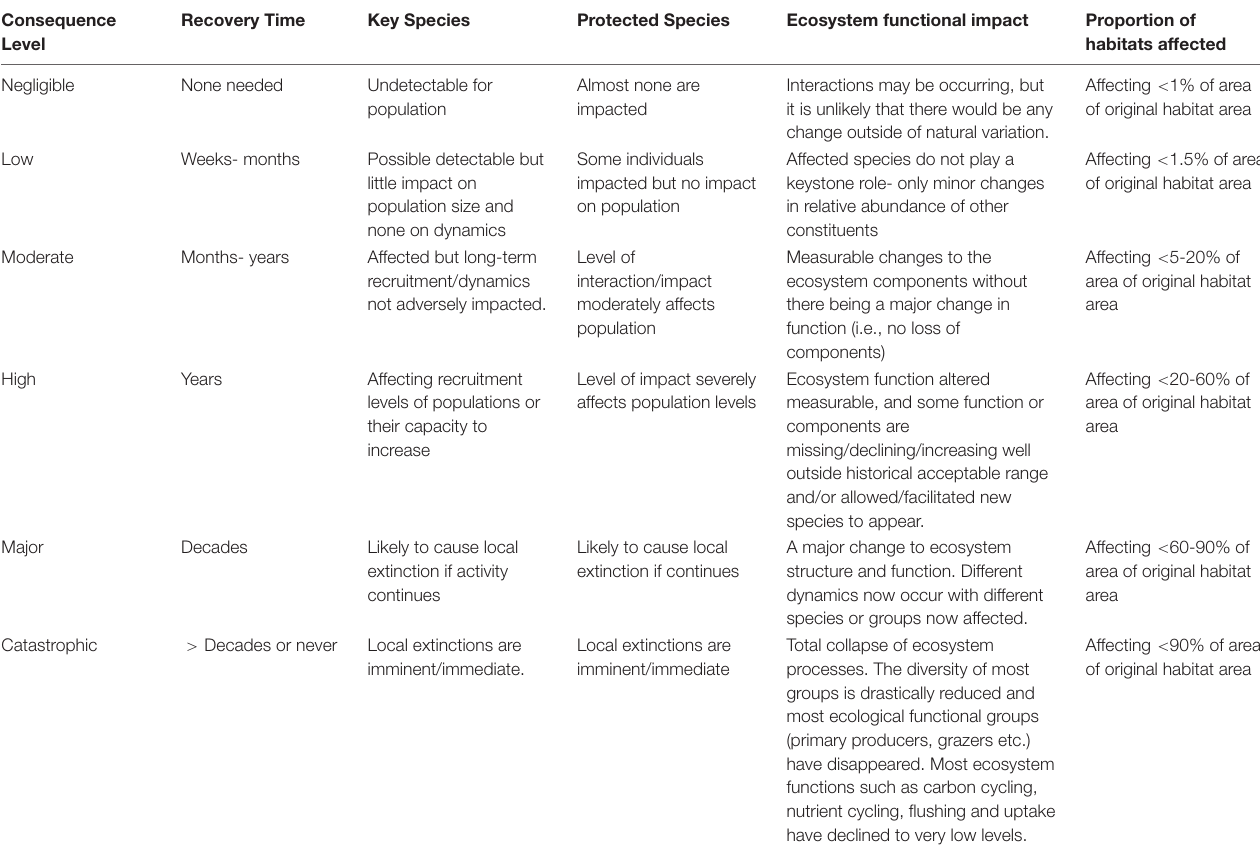
TABLE 3 | Consequence levels with descriptions. Adapted from Fletcher (2005).